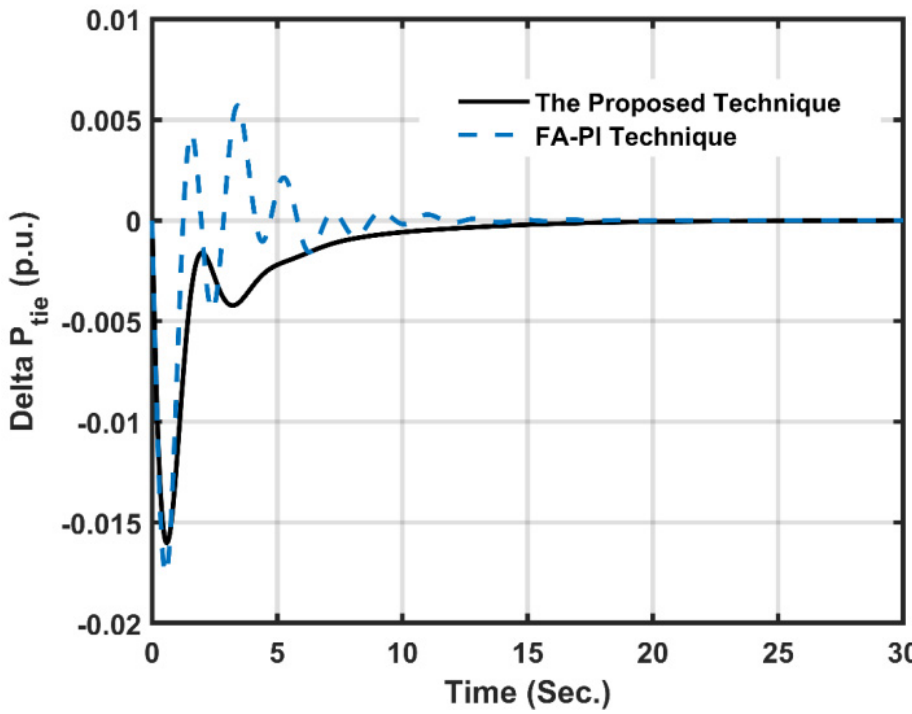
Figure 16. Tie line power deviation under disturbance in thermal demand.